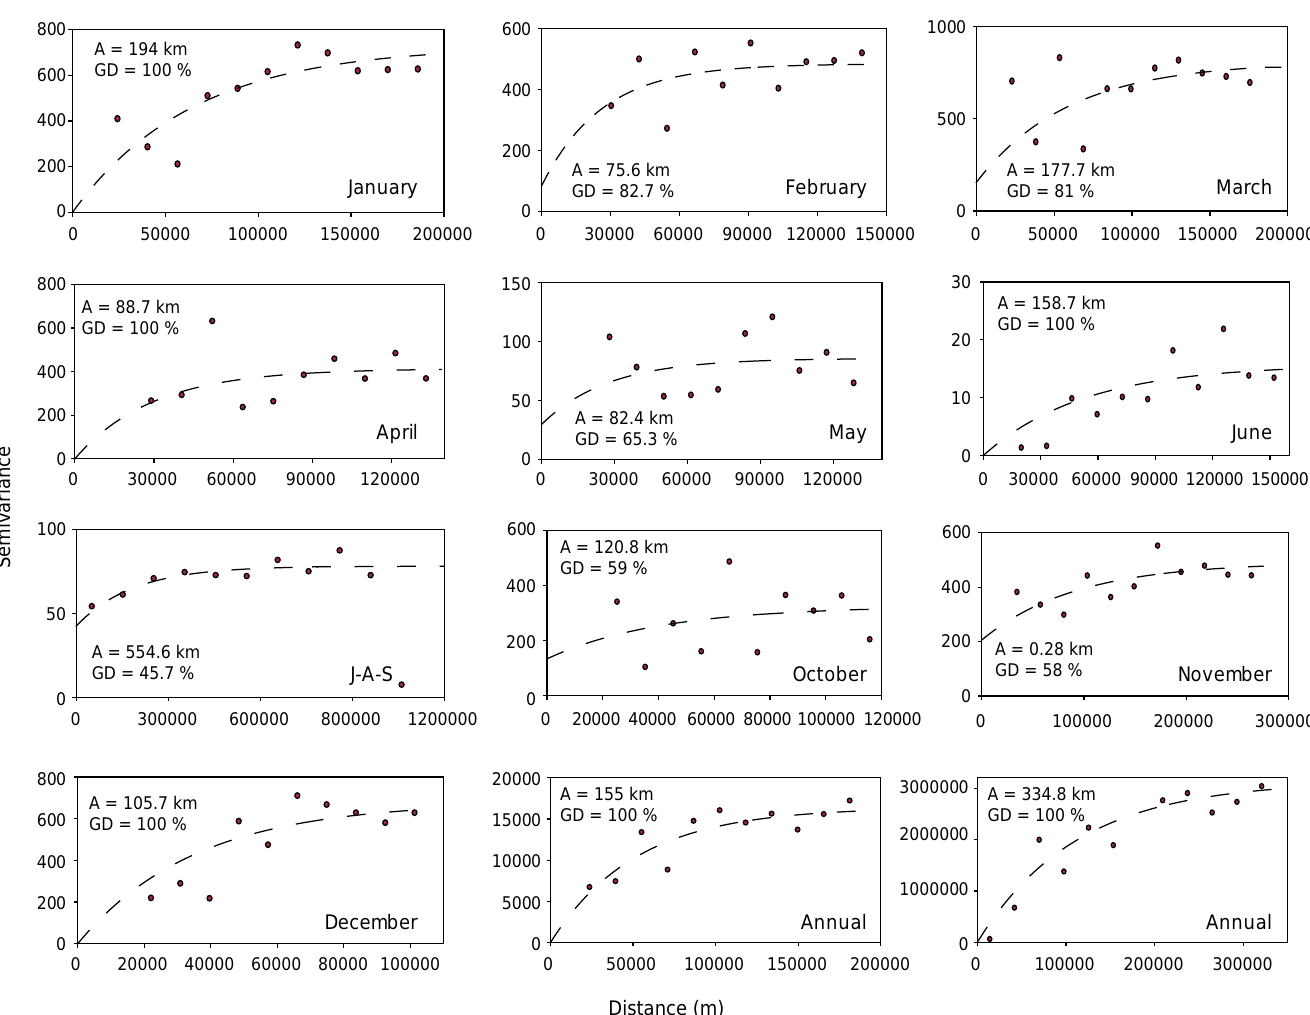
Figure 3. Semivariogram models of the residues adjusted for the monthly and annual rainfall data and R-factor in the State of